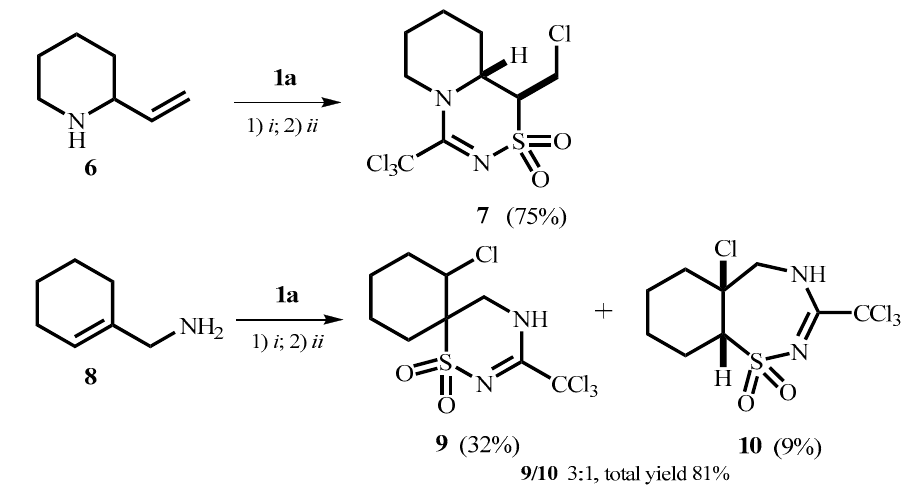
Scheme 4. One-pot synthesis of 7 , 9 , 10 via heterocyclisation of isomeric alkenylamines 6 and 8 with 2,2,2-trichloro- N -(chlorosulfonyl)acetimidoyl chloride 1a . Reagents and conditions: (i) Et 3 N, CH 2 Cl 2 , 0–20 ◦ C, 2 h. (ii) AlCl 3 , CH 2 Cl 2 , r.t., 24